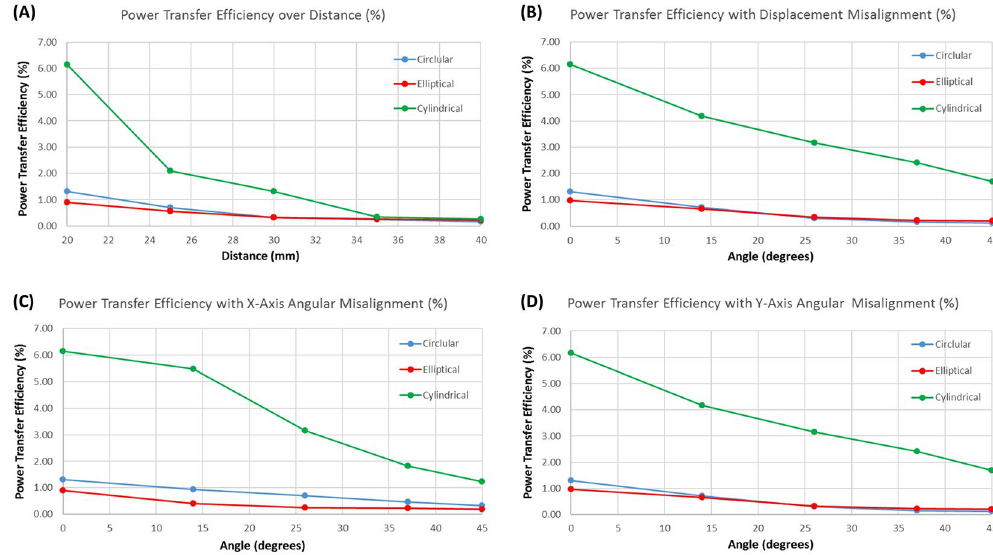
Figure 5. Power Transfer Efficiency Measurements. ( A ) A range of distances from 20 mm to 40 mm at intervals of 5 mm. ( B ) Displacement misalignment from 0 to 45 degrees. ( C ) X-axis angular misalignment from 0 to 45 degree. ( D ) Y-axis angular misalignment from 0 to 45 degree. The wrapped half-cylindrical antenna with the meandering structure provided the optimal power transfer efficiency as compared to the circular and elliptical